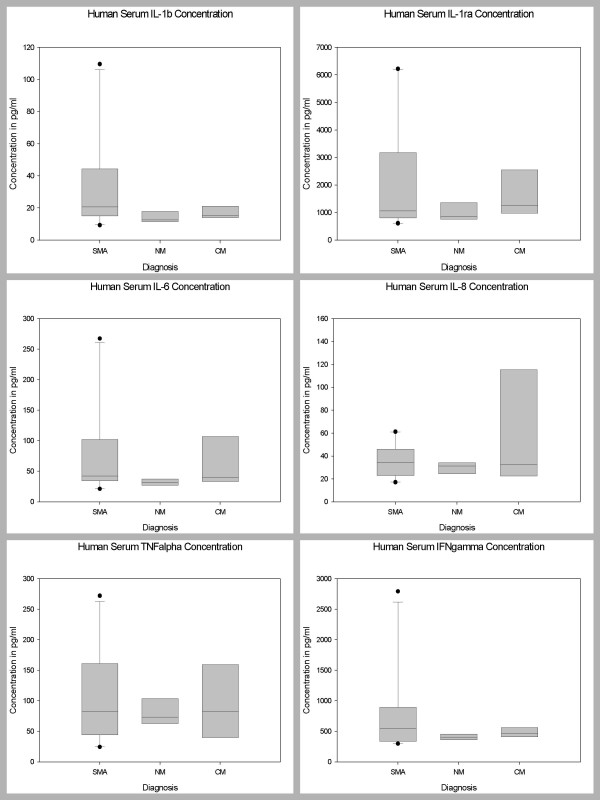
Postmortem serum biomarker levels of IL-1β, IL-1ra, IL-6, IL-8, TNF-α, and IFN-γ in children dying with CM, SMA, NM causes. CM, cerebral malaria; SMA, severe malarial anemia; NM, non-malaria. Box plots representing medians with 25th and 75th percentiles, bars for 10th and 90th percentiles, and points for outliers of biomarker concentrations. Only statistically significant P values after Bonferroni adjustment for the other biomarkers are shown.